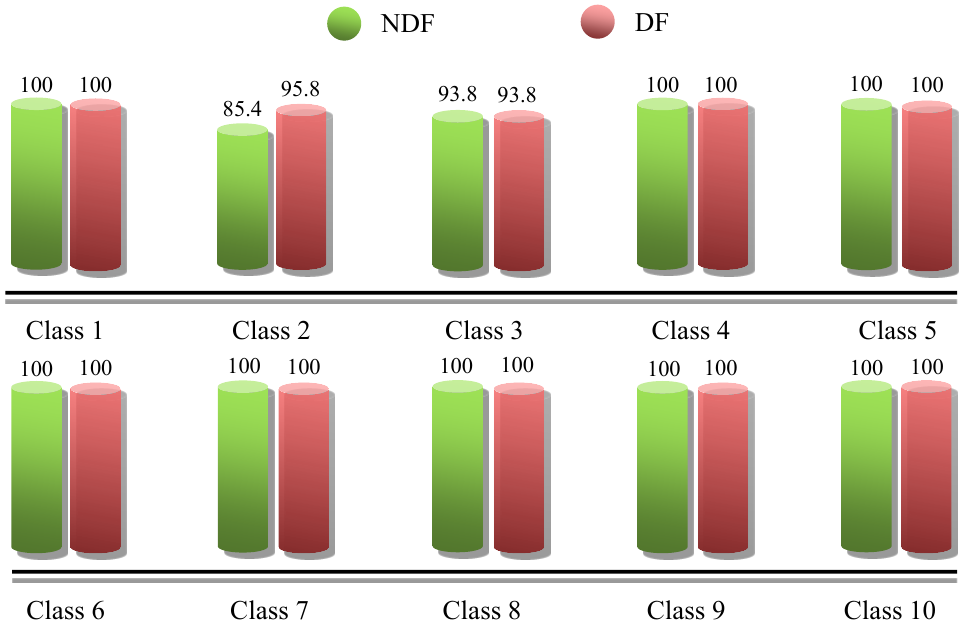
Figure 8. The average recognition rates with non-discriminative and selected discriminative features for the ten bearing fault classes.